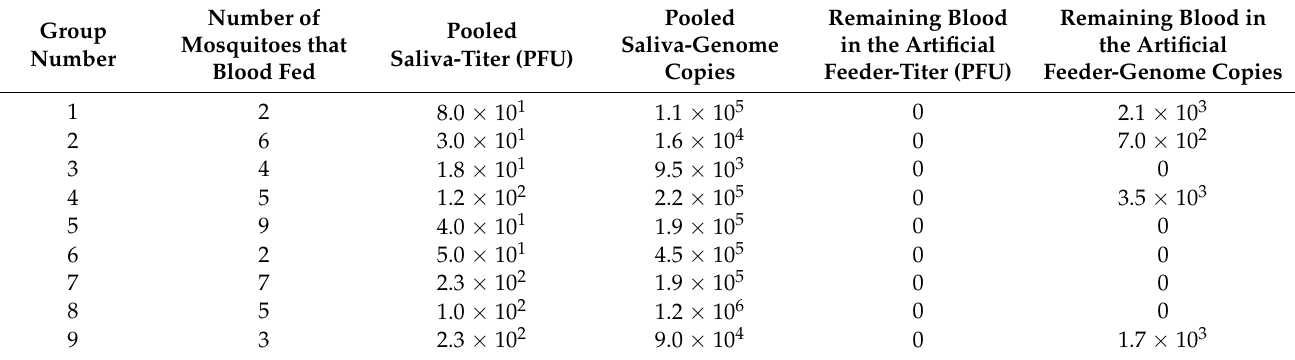
Table 5. Detection of ZIKV from forced salivations and from the blood remaining in the artificial feeders after infected mosquitoes blood fed on them. Group